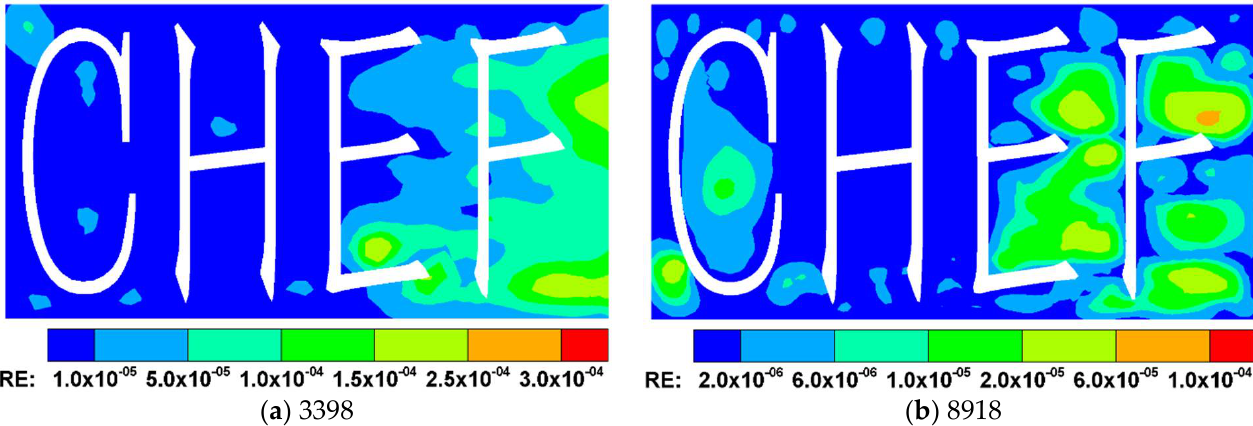
Figure 7. Distribution of 3398 collocation nodes.